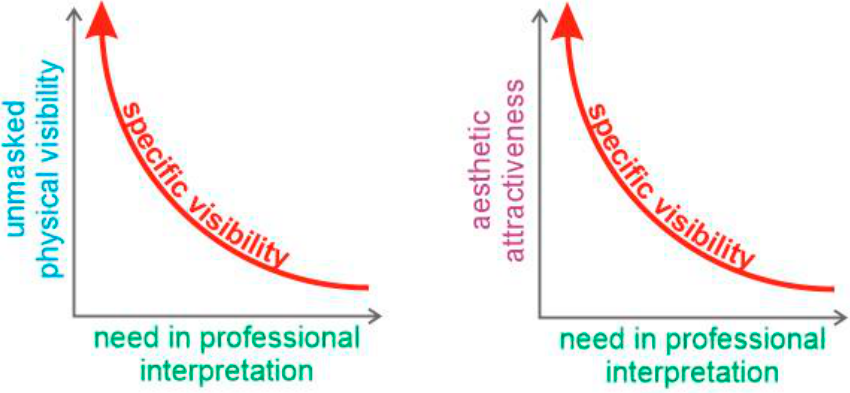
Figure 2. Dependence of geo-heritage specific visibility on the other characteristics of geo-tourist attractions.